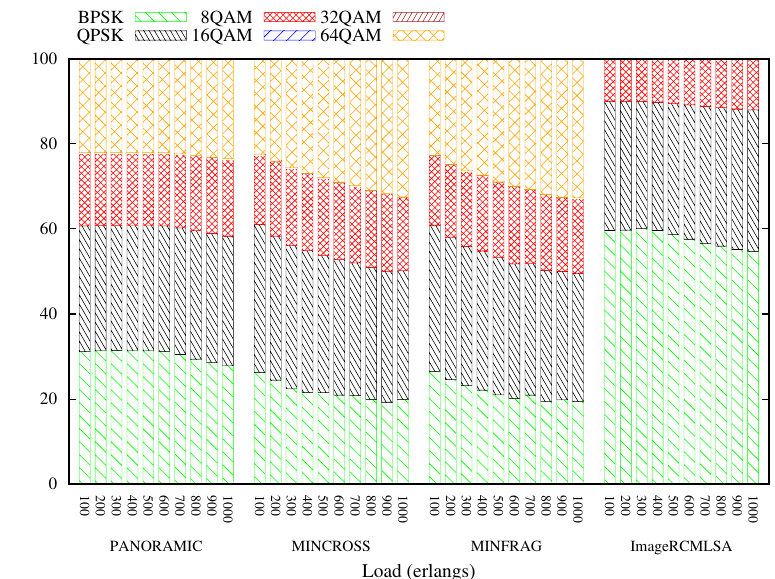
Figure 13. Modulation Format Percentage for USA topology.